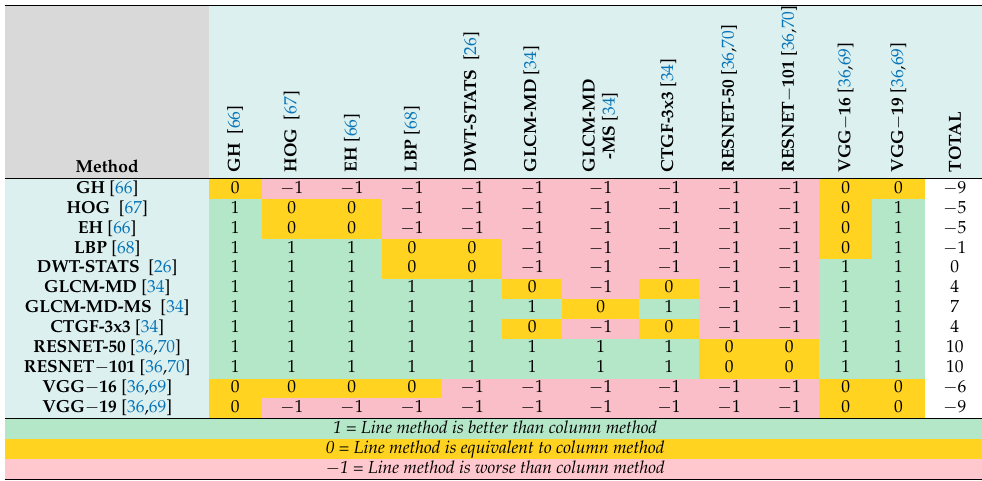
Table 5. Pairwise statistical comparison between different source attribution techniques.